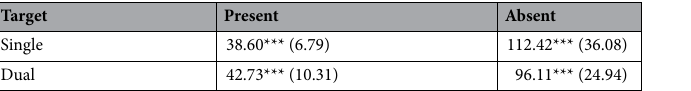
Table 4. Mean search slopes (in ms/item) and intercepts (in ms) with standard errors (in brackets), for target- present and target-absent trials in Experiment 2. Asterisks indicate that the respective slope differs significantly